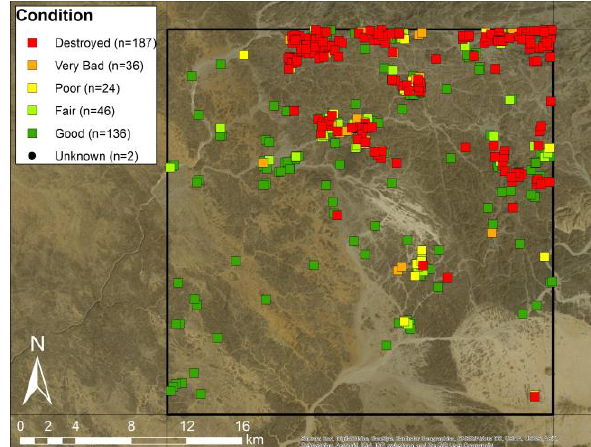
Figure 4. Distribution of sites by condition (Basemap: Esri, DigitalGlobe, GeoEye, Earthstar Geographics, CNES/Airbus DS, USDA, USGS, AEX, Getmapping, Aerogrid, IGN, IGP, swisstopo, and the GIS User